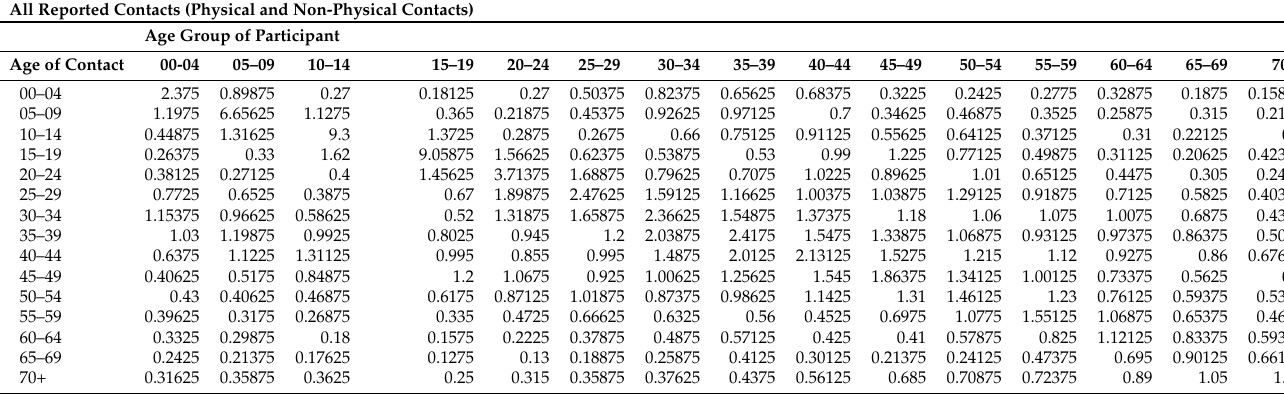
Table A1. Mossong data with 15 age groups.